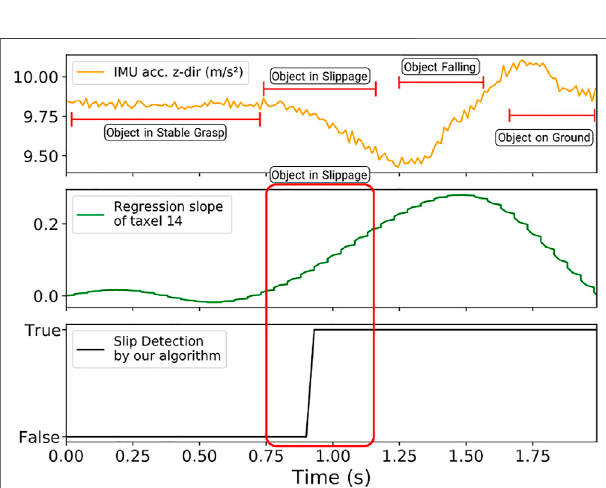
FIGURE 12 | Slip Detection Comparison Plots. From top to bottom, we havealow-pass fi lteredacceleration onthe z -axis,theregressionslopeonthe raw data, and the binary slip detection results from event